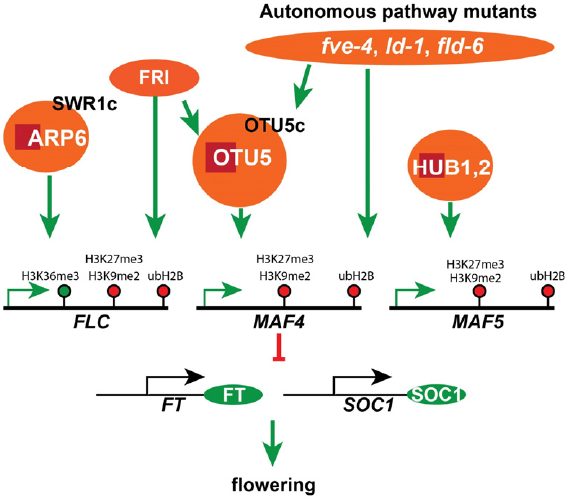
Figure 12. Arabidopsis OTU5 is a novel flowering suppressor. OTU5 acts, potentially in an associated protein complex (OTU5c), in parallel with SWR1c- and HUB1/2-mediated pathways to epigenetically activate FLC clade repressors and suppress flowering. OTU5 primarily activates FLC and, to a lesser extent, MAF5 , MAF4 , and MAF1 , which in turn suppress major flowering initiators FT and SOC1 to suppress flowering. Under unknown mechanisms, OTU5 is involved in decreasing the deposition of the activating histone mark H3K36me3 and in the upregulation of the suppressive histone marks H3K27me3 and H3K9me2 as well as ubH2B on specific loci, such as FLC , MAF4 , and MAF5 . OTU5-mediated flowering suppression is distinct from the SWR1c-mediated pathway,